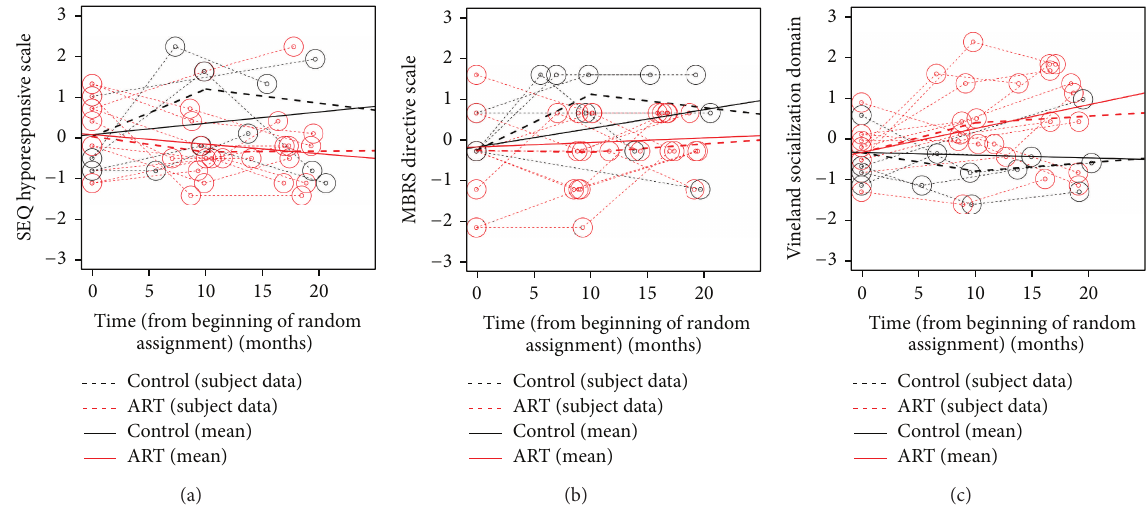
Figure 3: Three examples of nonlinear growth trajectories for outcomes with significant differences between ART and REIM groups: (a) SEQ hyporesponsive scale; (b) MBRS directive scale, and (c) Vineland socialization domain.